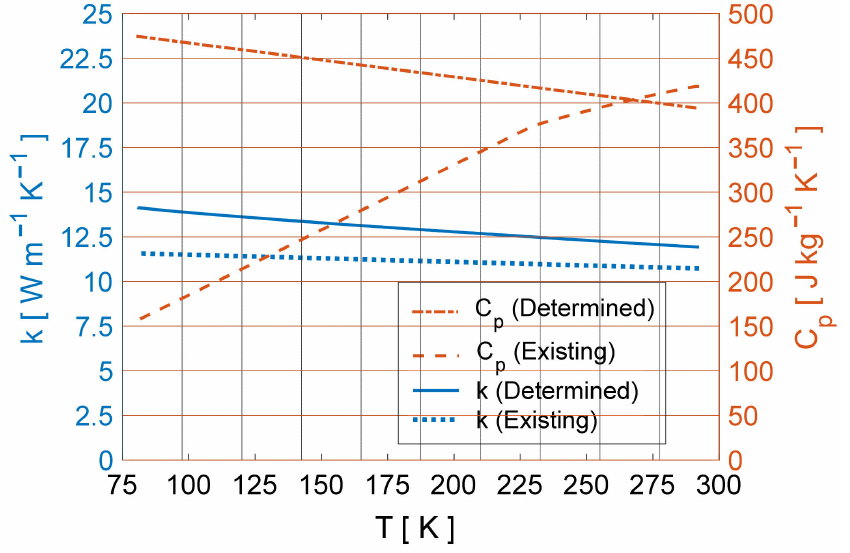
Figure 13. Dependence of YBCO thermal conductivity and specific heat capacity with temperature. The obtained characteristic of YBCO specific heat capacity at constant pressure (dashed-dotted brown line) presents an average value approximately equal to the one calculated in the final part of (cid:16) (cid:17) C PYBCO ≈ 430 J K − 1 kg − 1 Section 4 . Contrary to the characteristic in the literature for the YBCO layer in stacked tapes and coated conductors [19,20] (dashed brown line), the trend of the obtained characteristic for C PYBCO ( T ) decreases with temperature. This makes sense because the higher the bulk temperature, the less its capacity to absorb heat. This characteristic assumes values of the same order that are approximately equal to the ones found in the literature for temperatures around 260